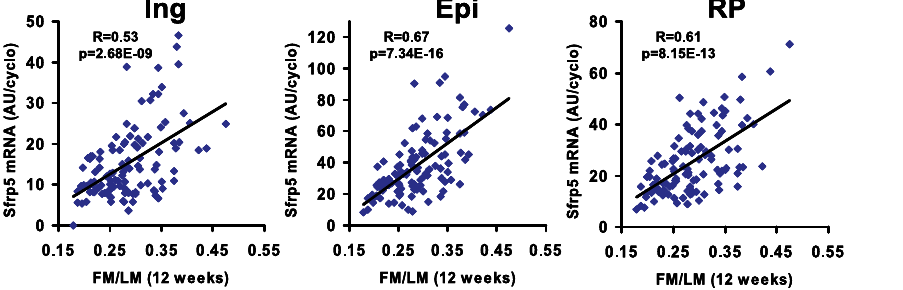
Figure 6. Positive Correlations between SFRP5 and Adiposity Regression analysis between SFRP5 mRNA levels and adiposity as estimated by the ratio of FM to LM in ING, EPI, and RP fat from 112 Mice Described in Figure 1B.